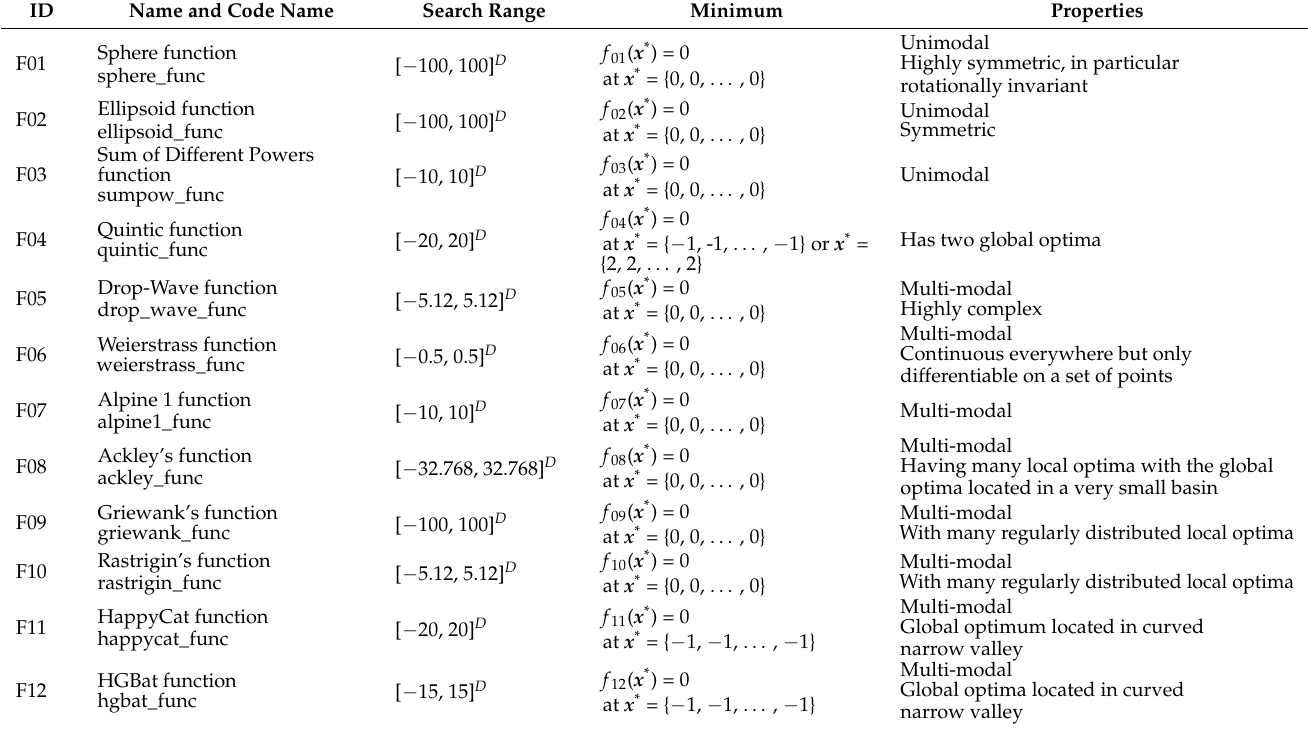
Table 3. The 12 objective functions used in the